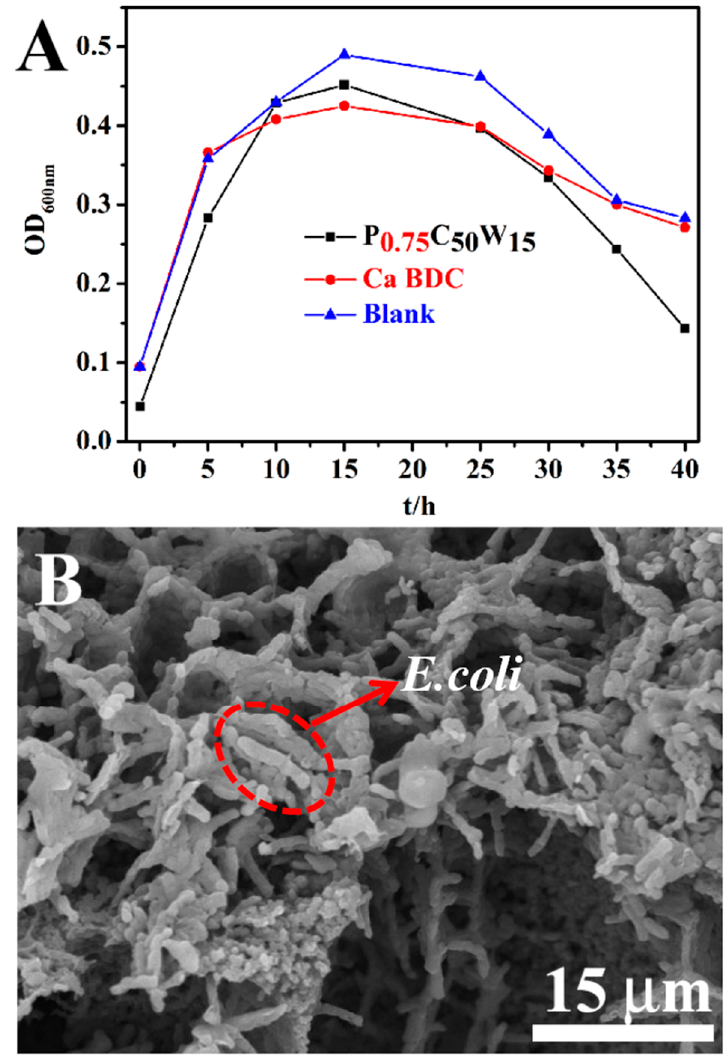
Figure12. ( A )Growth curves of E.coli under normal conditions and as-synthesized Ca-BDC and P 0.75 C 50 W 15 exist; ( B )the SEM images of E.coli grown in P 0.75 C 50 W 15